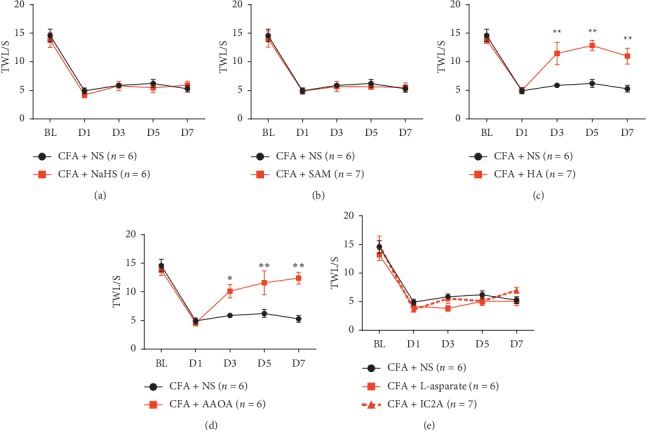
Inhibiting CBS activity alleviated pain sensation on the CFA mouse model. (a) H2S donor NaHS failed to reduce thermal pain behavior(P > 0.05); F (4, 40) 0.3923, P = 0.8129 (interaction), F (4, 40) 62.42, P < 0.0001 (time), and F (1, 10) 0.2892, P = 0.6025 (column factor). (b) CBS agonist SAM failed to attenuate thermal pain behavior(P > 0.05); F (4, 44) 0.08392, P 0.9870 (interaction), F (4, 44) 42.73, P < 0.0001 (time), and F (1, 11) 0.3571, P = 0.5622 (column factor). (c) HA notably attenuated thermal hypersensitivity (P < 0.01); F(4, 44) 6.669, P = 0.0003 (interaction), F(4, 44) 24.06, P < 0.0001 (time), and F (1, 11) 18.68, P = 0.0012 (column factor). (d) AOAA also remarkably relieved pain behavior (P < 0.05); F (4, 40) 7.503, P = 0.0001 (interaction), F (4, 40) 27.84, P < 0.0001 (time), and F (1, 10) 12.95, P = 0.0049 (column factor). (e)Theinjection of IC2A and L-aspartate had no effect on relieving thermal pain(P > 0.05); F(8, 64) 0.8894, P = 0.5306 (interaction), F(4, 64) 81.15, P < 0.0001 (time), and F (2, 16) 2.716, P = 0.0965 (column factor). Data MEANS± SEM